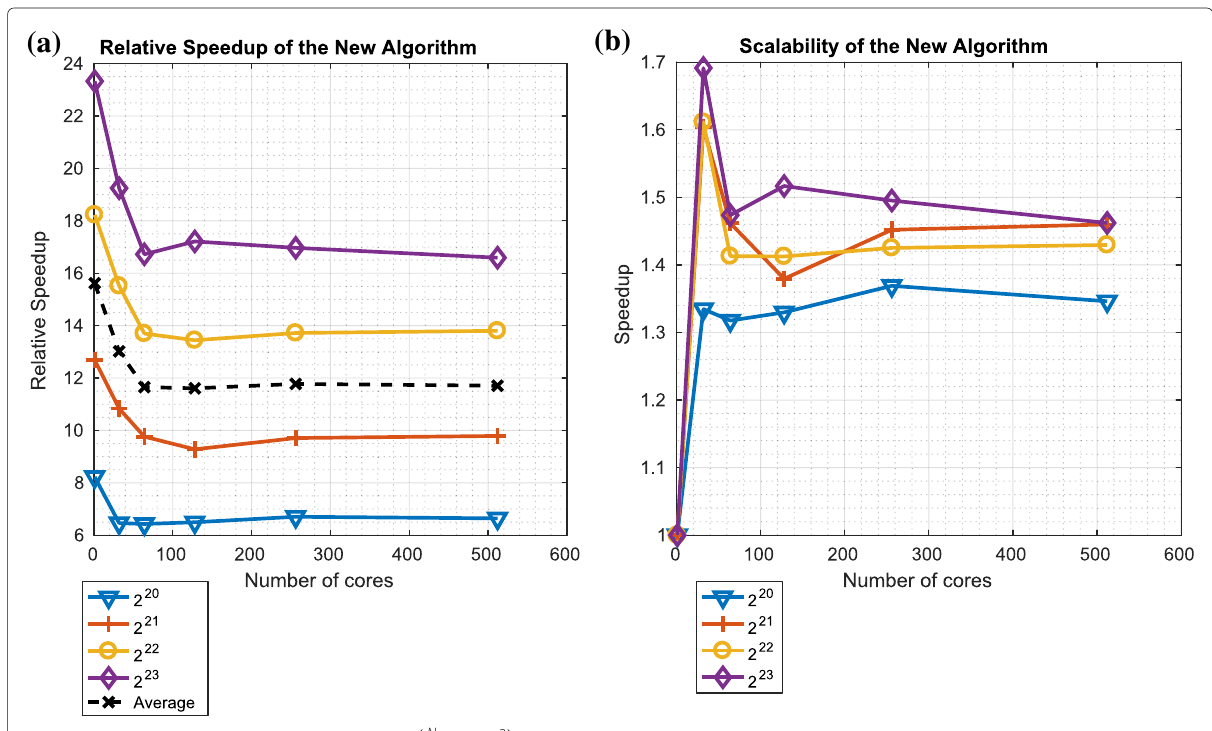
Fig. 15 Relative speedup and scalability of the O